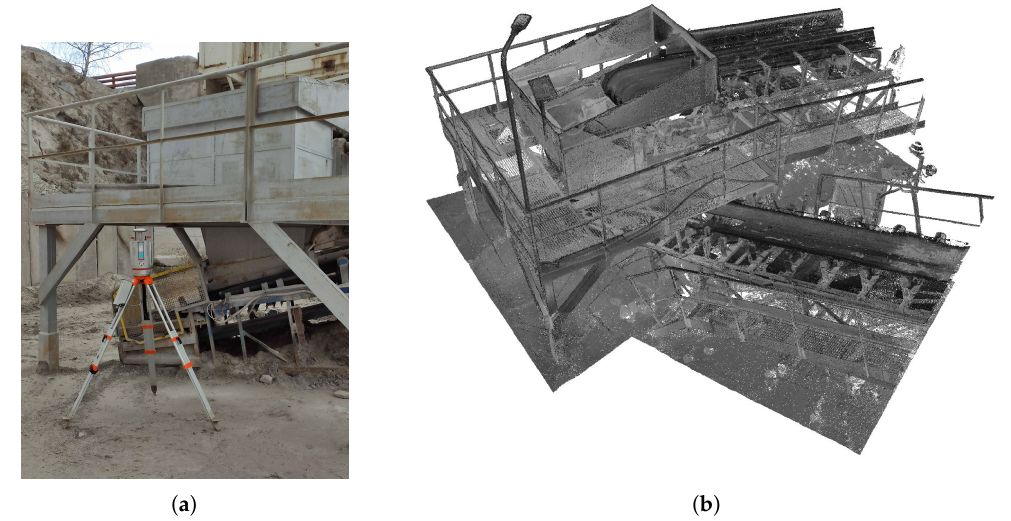
Figure 5. Laser scanning: ( a ) Riegl V400i scanner and ( b ) point cloud of transfer station.